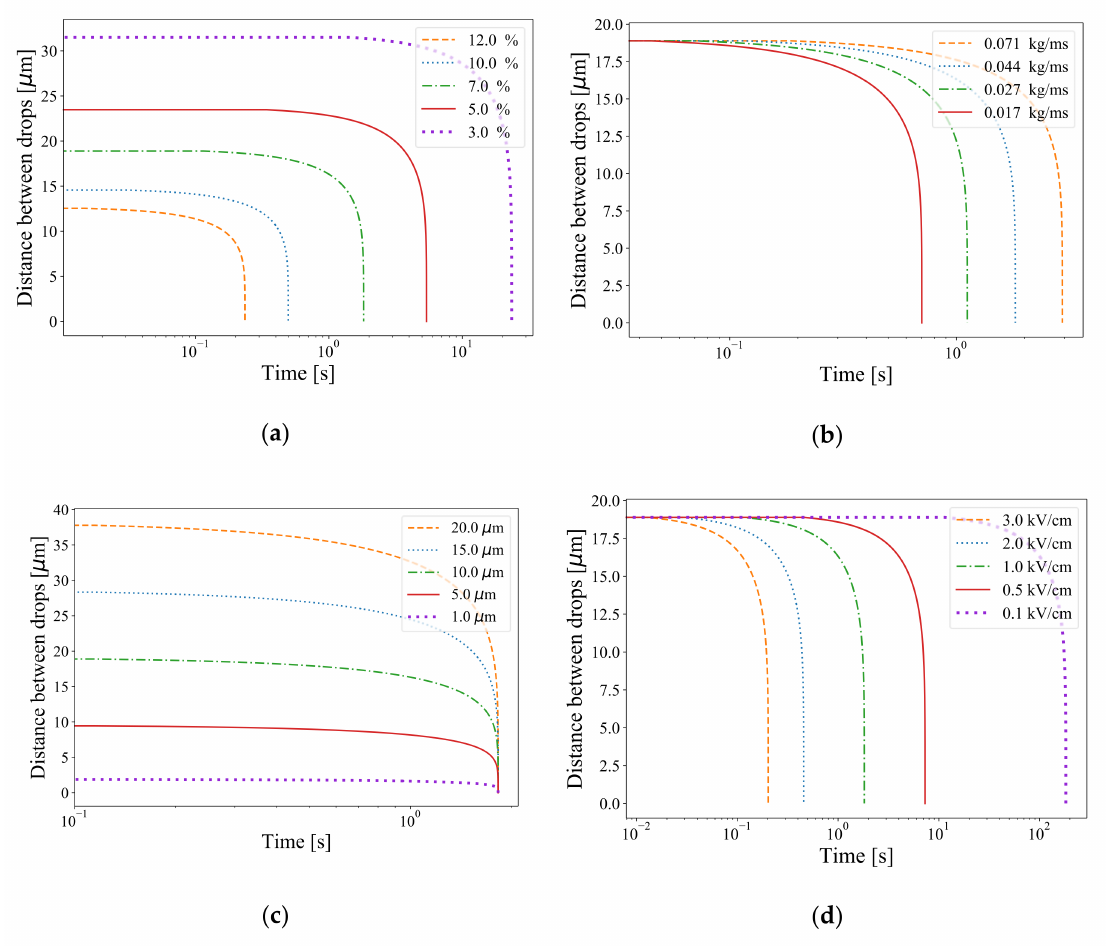
Figure 3. Effect of the ( a ) water content x , ( b ) oil viscosity µ o (temperature), ( c ) size of the droplets (assuming two droplets of the same size), ( d ) electric field strength E . In all cases, the rest of the operating conditions correspond to the standard conditions mentioned in Table 2.